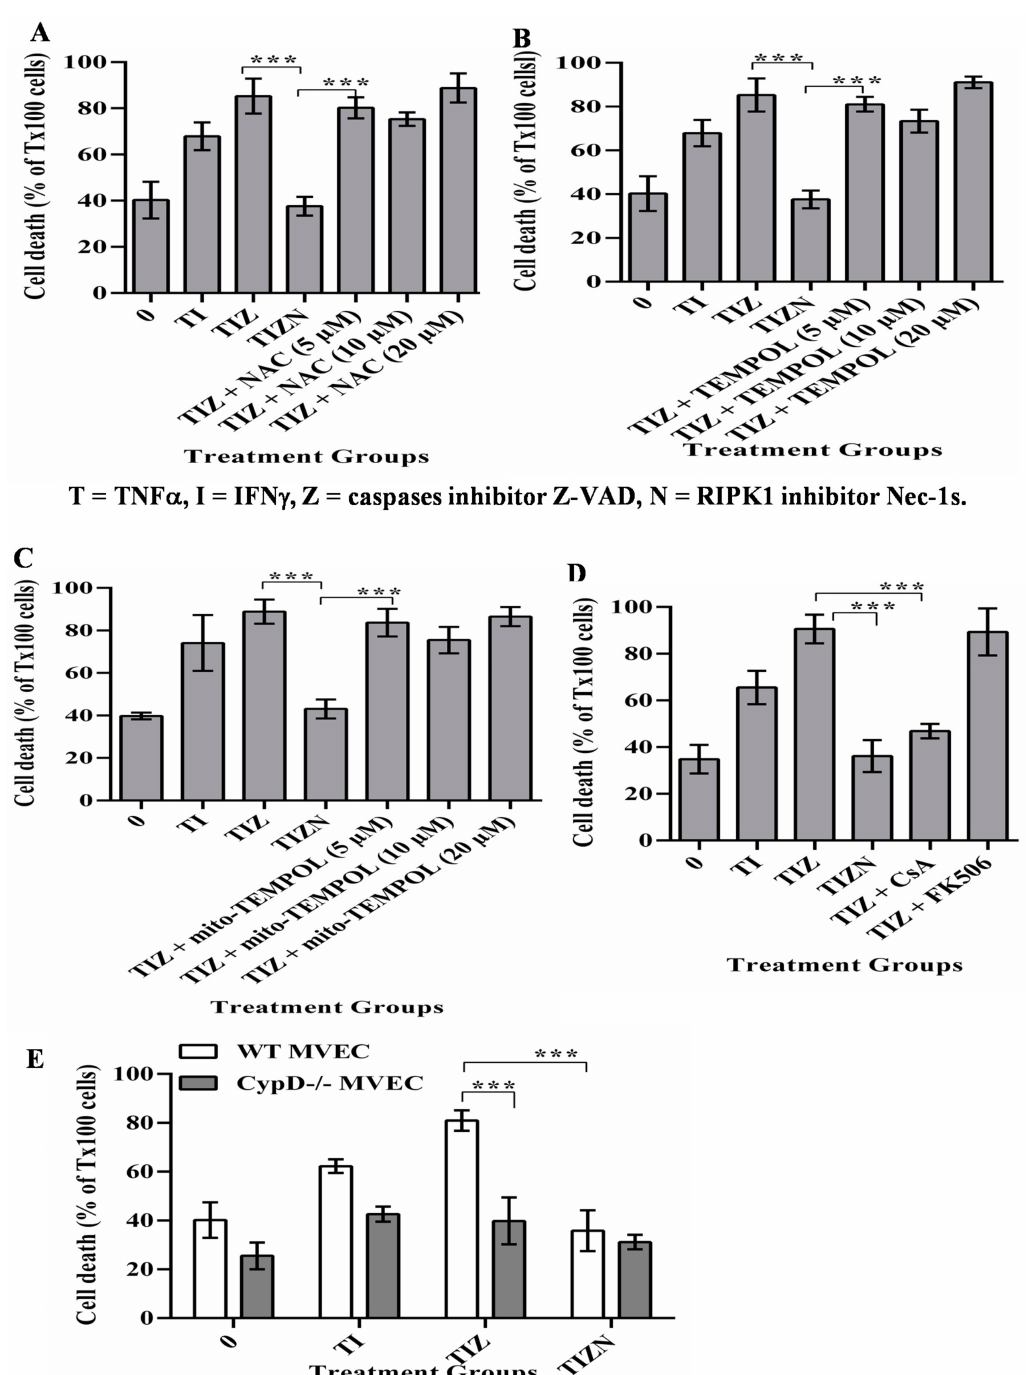
Figure 2. CypD, not ROS, contributes to MVEC necroptosis under the in vitro simulation of IRI conditions. ( A – C ). MVECs were subjected to cold hypoxia-reoxygenation with cytokines, as described in Figure 1. ROS scavenger NAC, TEMPOL or Mito-TEMPOL were added, respectively. A small amount of (0.1%) Triton X-100 (Tx100) was used to induce maximum death with 100% cell staining of SYTOX green. % EC death = sample count/count of Triton-X100-treated cells. Data are shown at 24 h post-reoxygenation as the mean ± SD of triplicates and representative of at least 3 independent experiments. ( D ) CypD inhibitor—CsA and control FK506 at 10 µ M was added before hypoxia. Data are shown as the mean ± SD and representative of at least 3 independent experiments. ( E ) Wild-type (WT) and CypD − / − MVECs were subjected to in vitro cold hypoxia-reoxygenation with cytokines, as in Figure 1. Data are shown as the mean ± SD and representative of at least 3 independent experiments. *** p ≤ 0.001; 1-way ANOVA and Tukey’s multiple comparisons